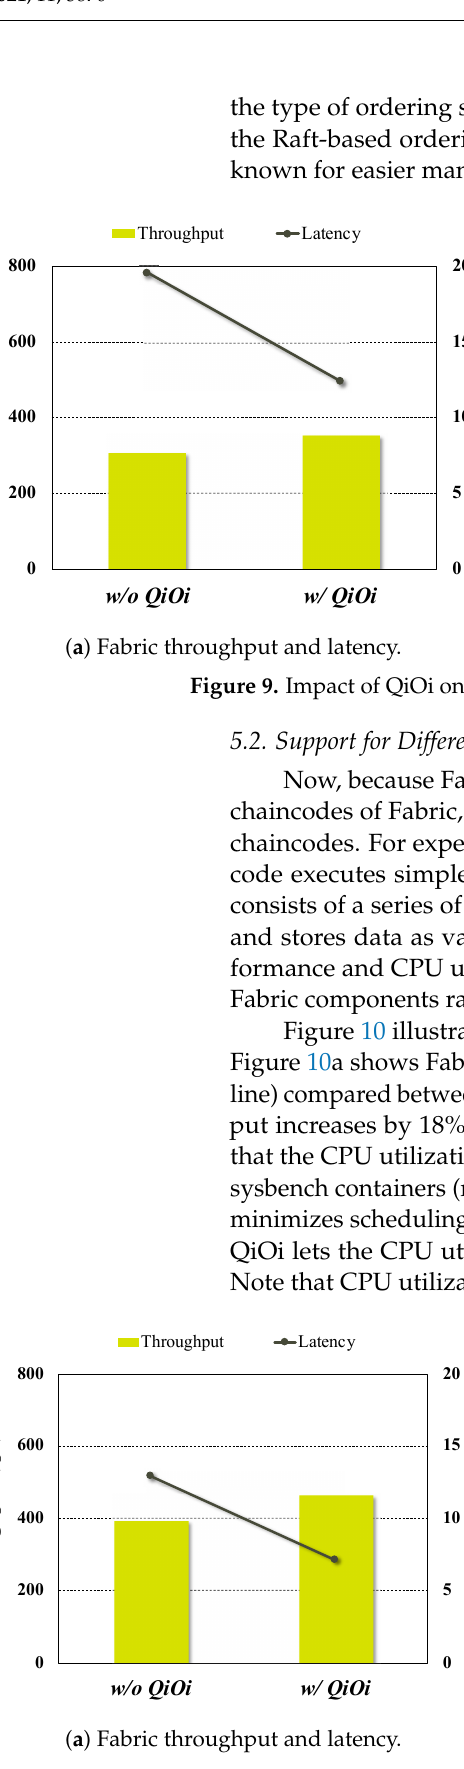
Figure 10. Impact of QiOi on Fabric using simple